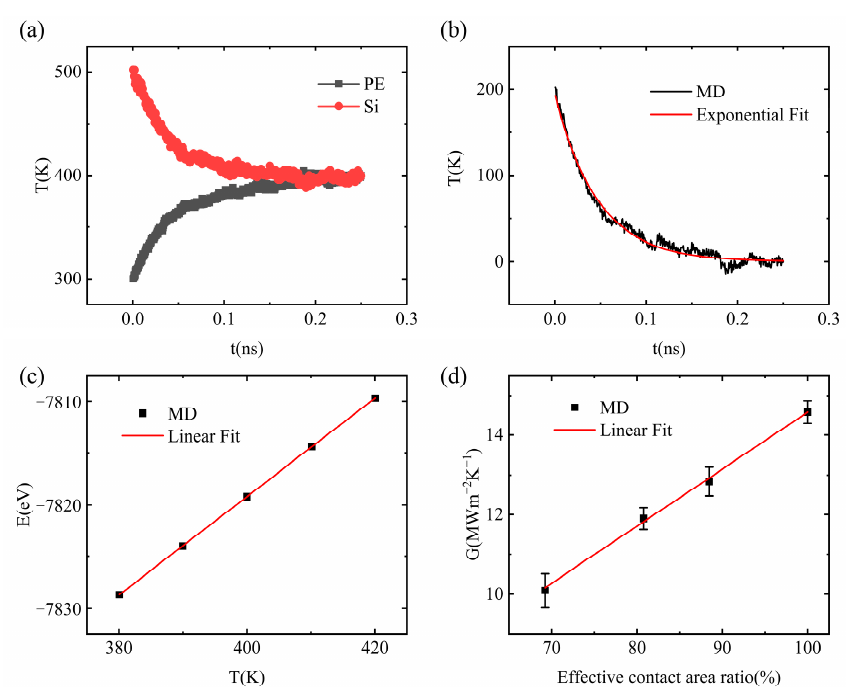
Figure 2. ( a ) Temperature evolution diagram of polymer and silicon with time during simulation. ( b ) Evolution of temperature difference between polymer and silicon with time during simulation. ( c ) The heat capacity of silicon at 400 K is calculated and linearly fitted by calculating the relationship between temperature and energy. ( d ) The relationship between the interfacial thermal conductance of a single vacuole model at 500 K and effective contact area